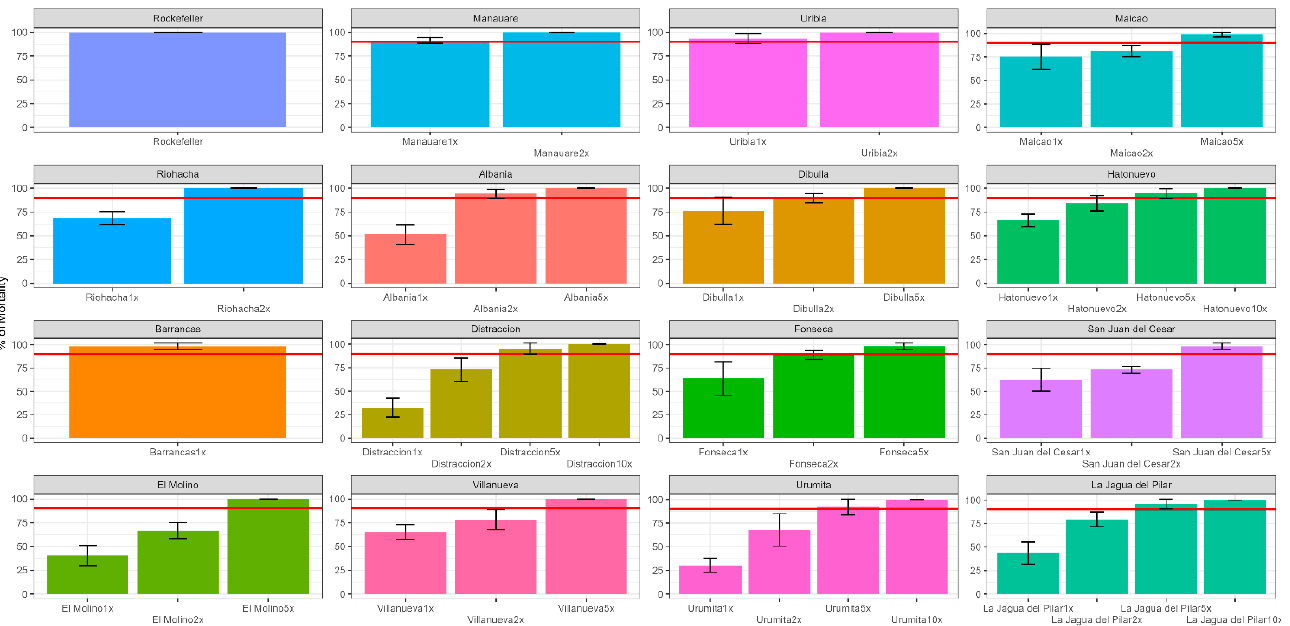
Figure 2. Mortality (with standard deviations) of Ae. aegypti following exposure to 1 × DD, 2 × DD, 5 × DD, and 10 × DD of permethrin in bottle bioassays. The red lines indicate the resistance threshold (90% mortality).